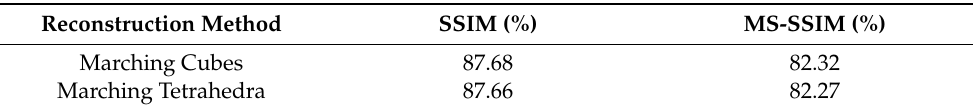
Table 1. SSIM and MS-SSIM for Marching Cubes and Marching Tetrahedra. Reconstruction